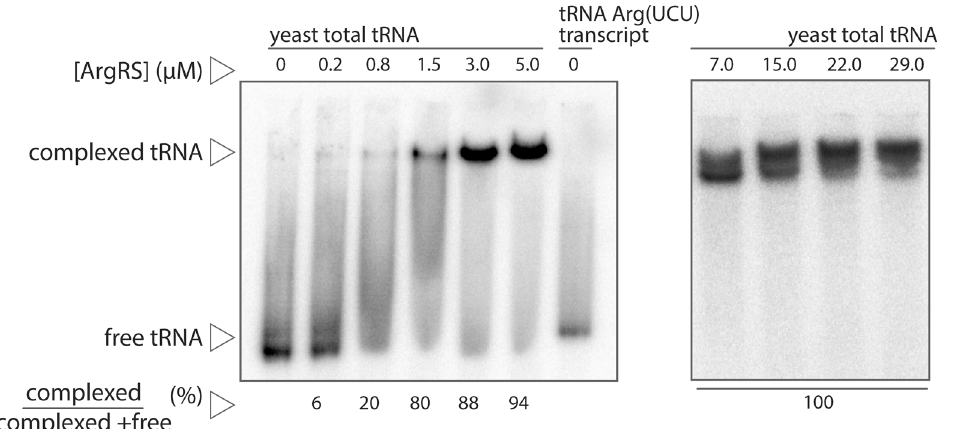
Fig 2. Separation of free and complexed tRNAs by EMSA. Radiolabeled yeast total tRNAs and in vitro transcribed yeast tRNA Arg (UCU) (as a migration control) were incubated with 0 to 29 μ M of yArgRS and separated on a 6% non-denaturing polyacrylamide gel. The fraction of shifted or complexed tRNAs is